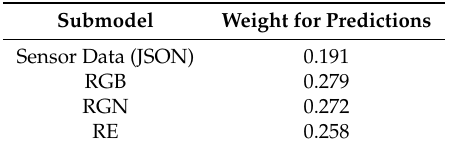
Table 4. Weights for the predictions of each submodel.